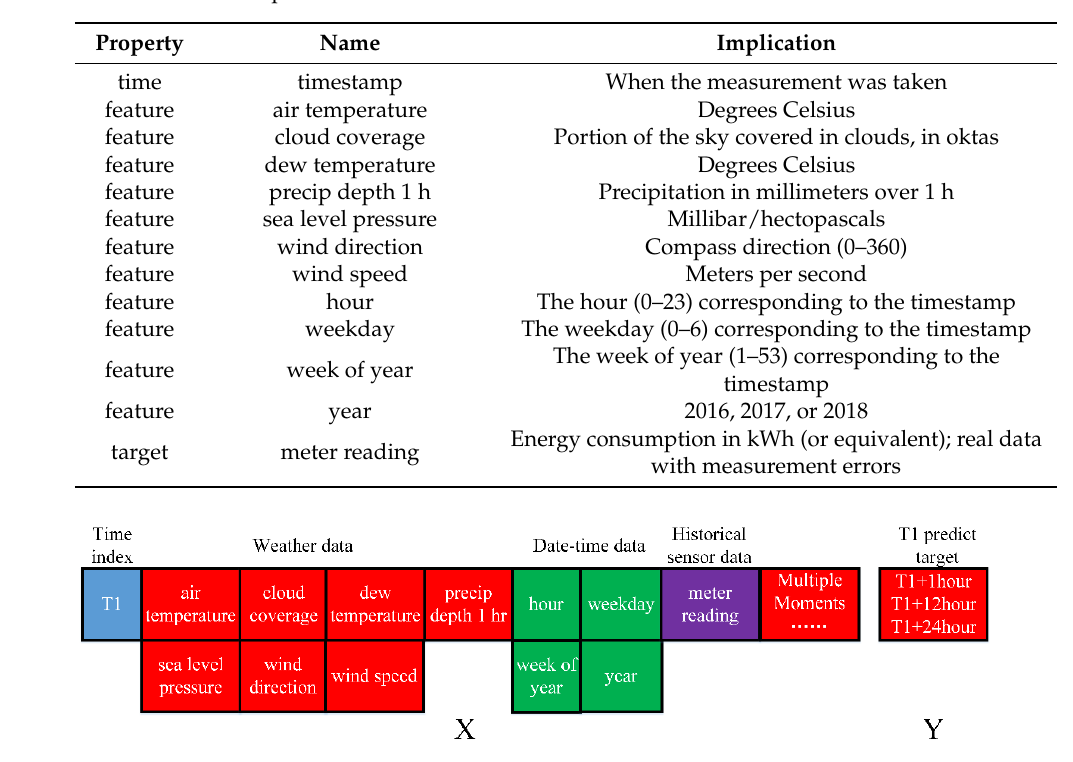
Table 1. Data description in GEPIII.